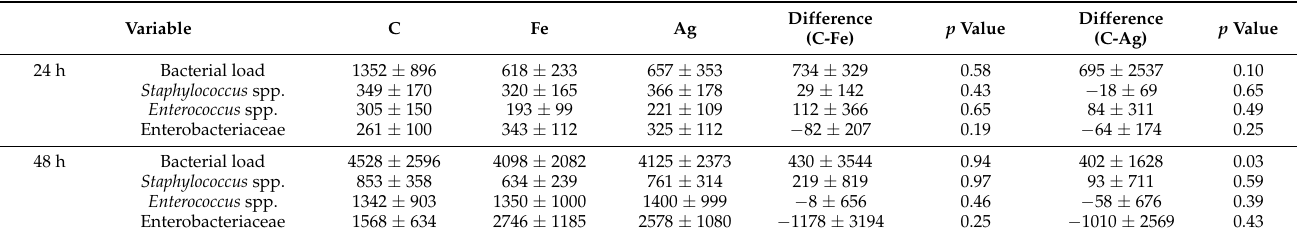
Table 3. Microorganisms (cfu/mL, means ± SEM) isolated from ram semen samples ( n = 21) after 24 h and 48 h of incubation at 37 ◦ C on blood agar and selective culture